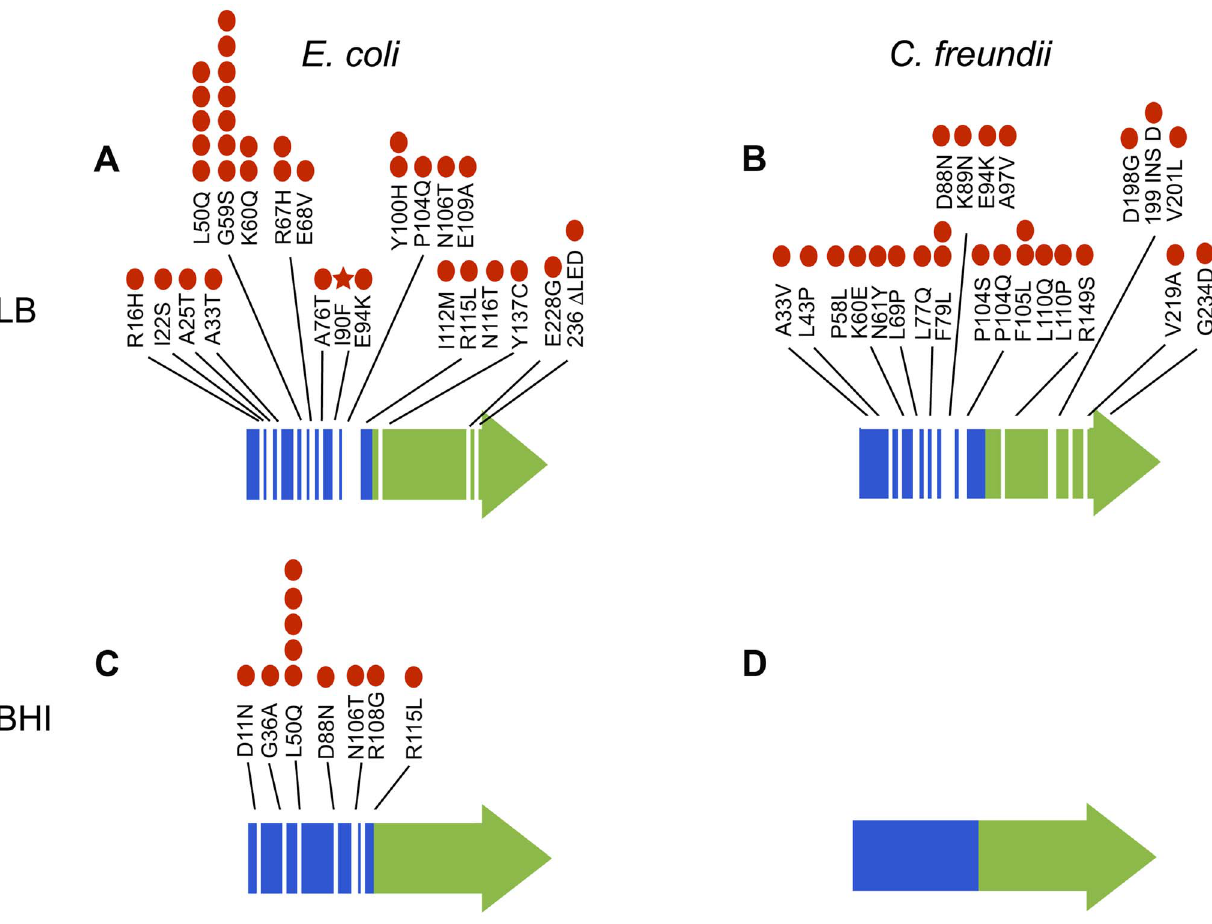
Fig. 7. Mutations in arcA evolved repeatedly and with remarkable diversity both within and among populations of E.coli evolved in LB (A) and BHI (C) and C.freundii populations evolved in LB (B) and BHI (D). Specific mutations to arcA identified in the evolved populations are indicated. The red dots represent the number of populations with that specific mutation (out of twelve LB and eleven BHI populations for each strain). The red star indicates the mutation that was fixed in LB5. No mutations in arcA were identified in the BHI-evolved C. freundii populations. The receiver domain that includes the site of phosphorylation (Asp-54) is indicated in blue and the DNA binding domain in green.